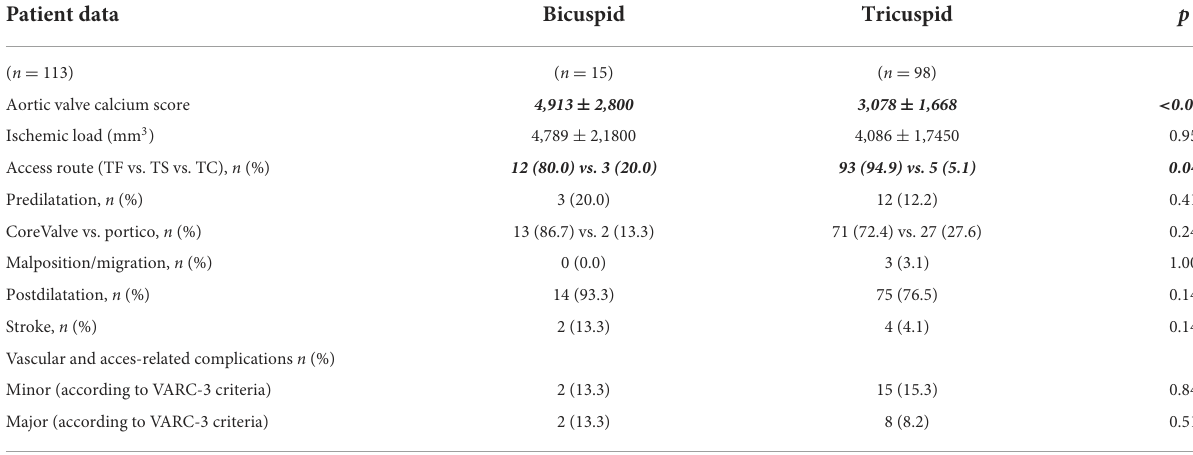
TABLE 7 Procedural characteristics of patients with the bicuspid and tricuspid